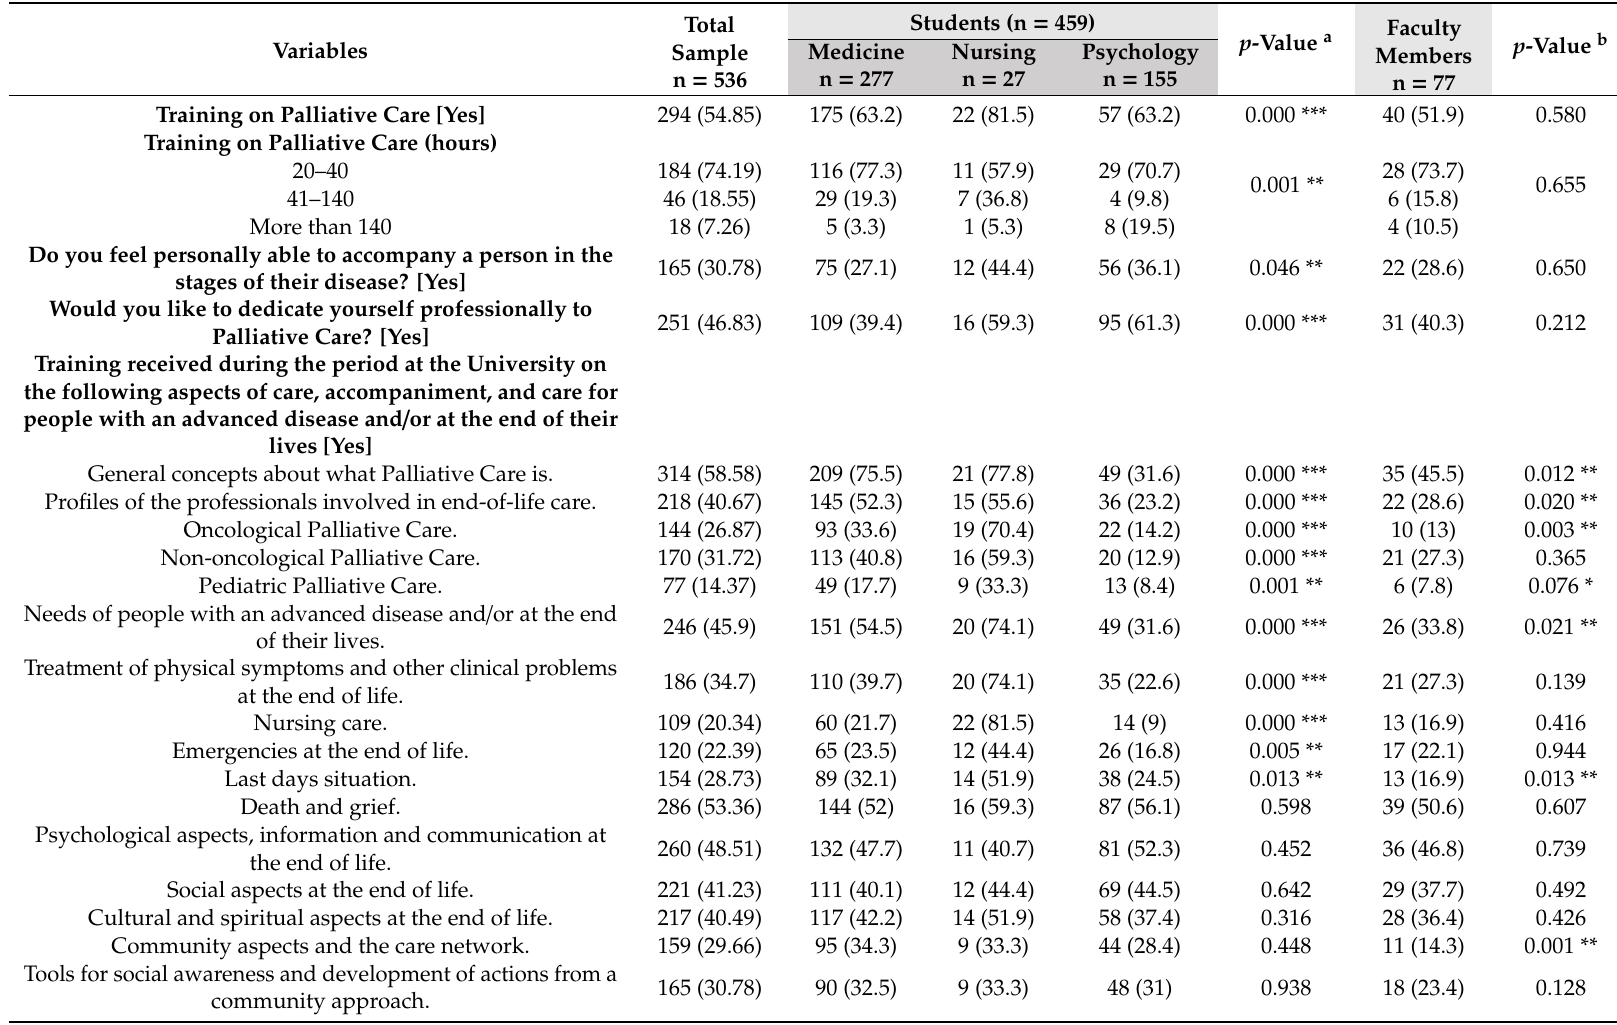
Table 2. Training needs of lecturers and students related to the care of persons with an advanced disease and / or at the end of their lives (n = 536).